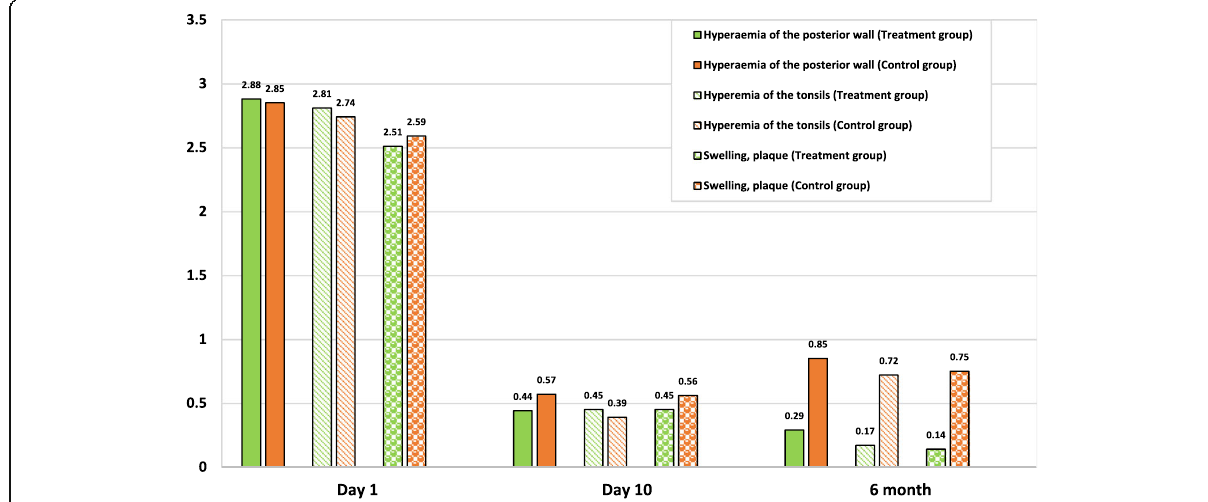
Fig. 2 Dynamics of the severity of the principal symptoms of tonsillitis in points